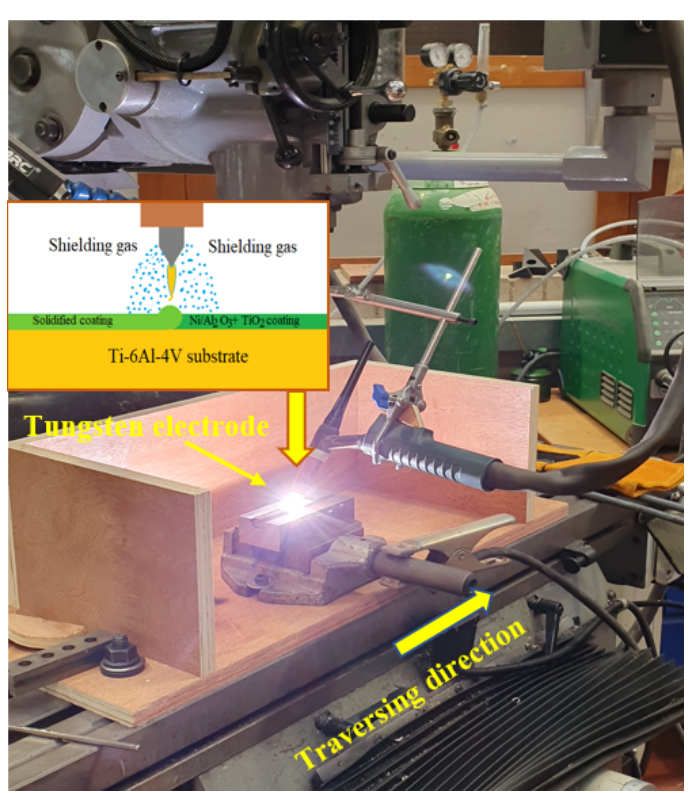
Figure 1. Set up of the GTAW surface melting and micro-alloying process.